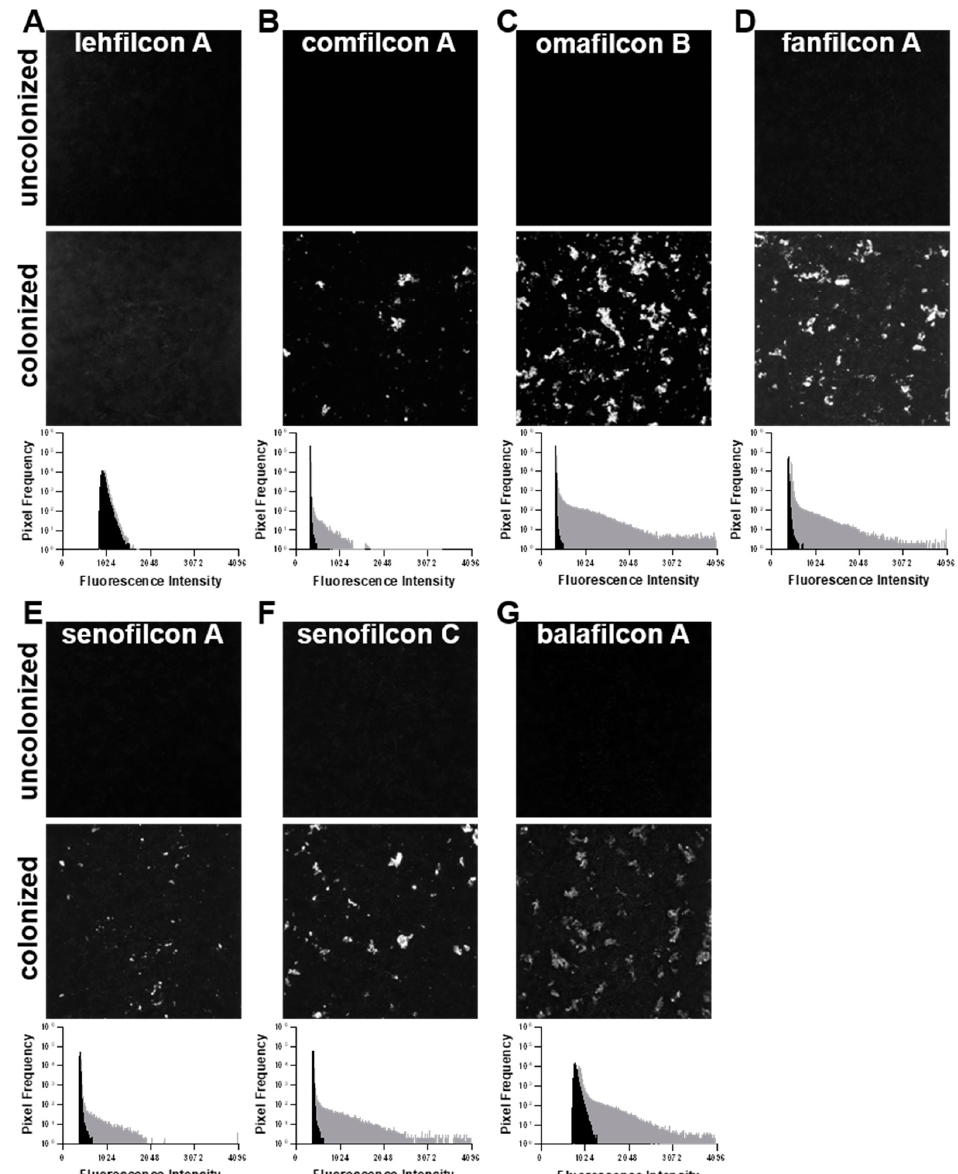
Figure 4. Confocal microscopy of contact lenses colonized with TAMRA-stained S. marcescens . Im- age size of 0.42 mm × 0.42 mm taken from the central region of lehfilcon A ( A ), comfilcon A ( B ), omafilcon B ( C ), fanfilcon A ( D ), senofilcon A ( E ), senofilcon C ( F ), and balafilcon A ( G ) was collected at 10X magnification. Uncolonized control contact lenses (top panel) and S. marcescens -colonized contact lenses (middle panel) are shown for comparison. Histograms (bottom panel) depict the frequency distribution of fluorescent pixel intensities from uncolonized (black) and colonized (gray) contact lenses.